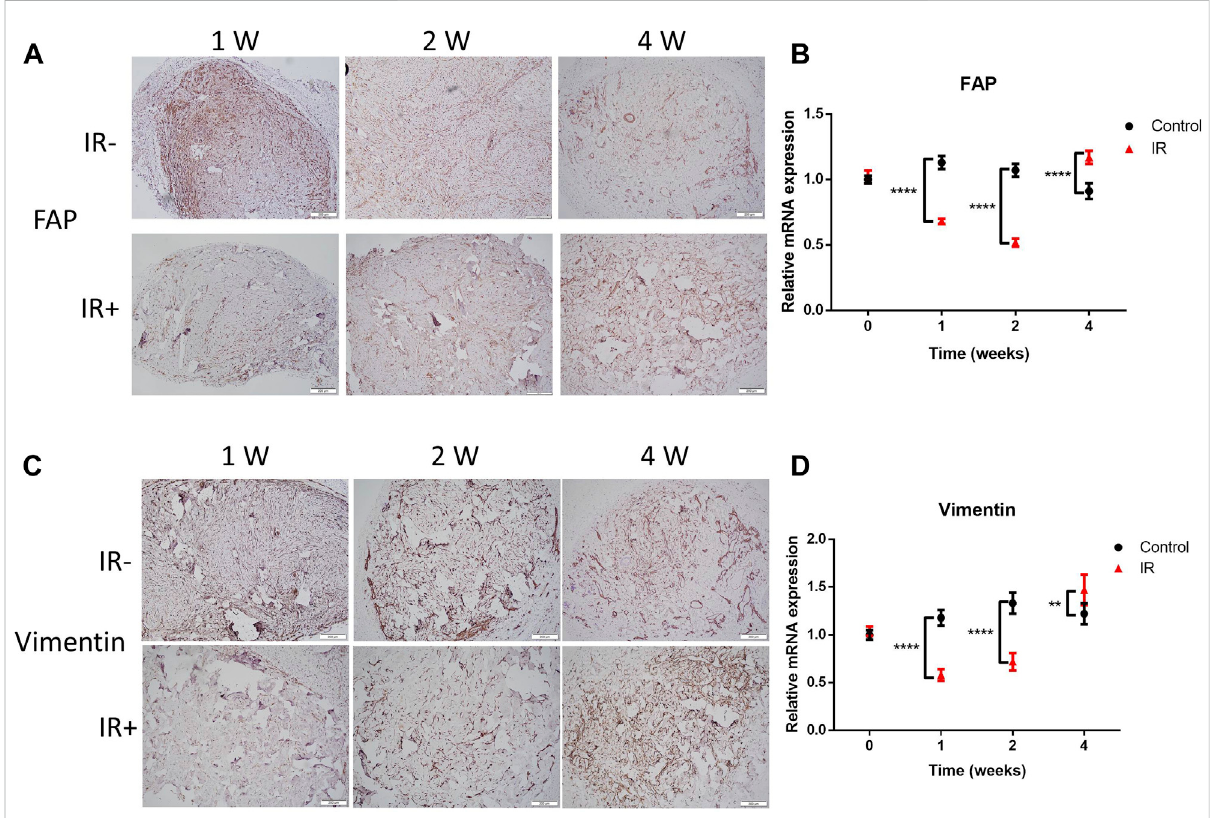
FIGURE 3 Radiation-resistant tissue was quickly restored, with increased FAP and vimentin expression. (A – C) Graft sections were stained for FAP and vimentin for IHC analysis. The scale bar represents 200 µm. (B – D) Comparison of the mRNA levels of FAP and vimentin between the two groups of grafts. Data from 3 experiments were combined and are presented as the mean ± SD. n = 6; **, p < 0.01; ****, p <